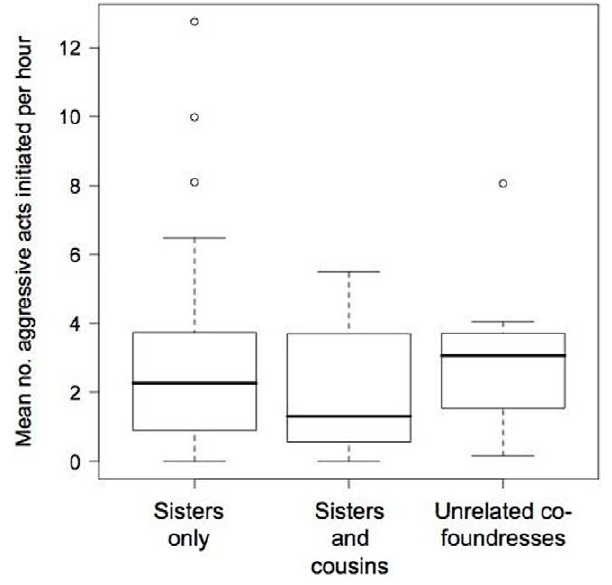
Figure 6. Aggression levels within founding groups. Mean aggression rates on nests where co-foundresses were all sisters, cousins and sisters, or contained at least one wasp that was not related to the rest of the group are